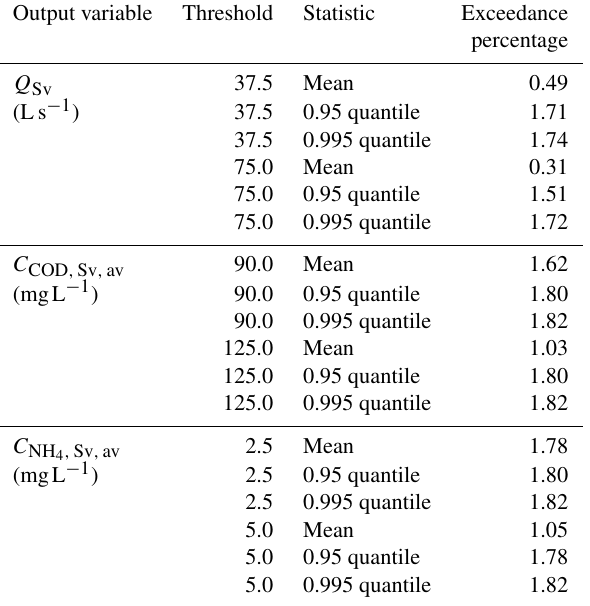
Table 6. Frequency (percentage) over time that environmental thresholds are exceeded for different statistics of the overflow spill flow, COD, and NH 4